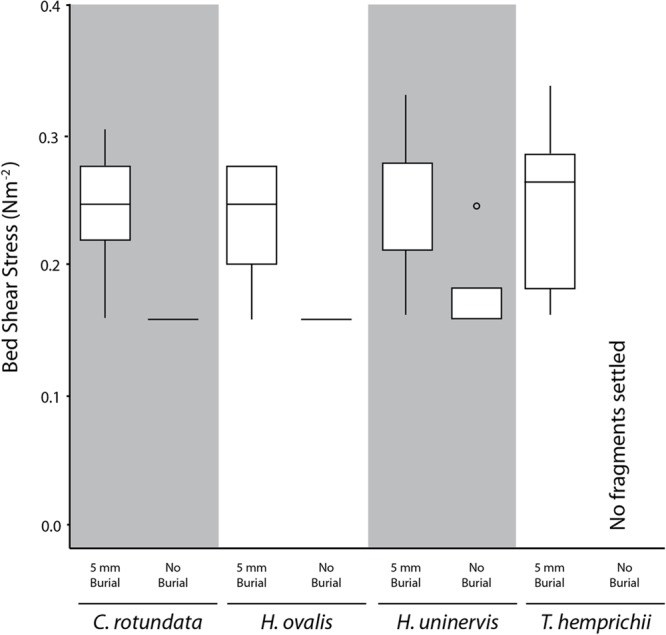
Box plot of the wave-generated bed shear stress (N m-2) needed to dislodge fragments of different species under 20 mm burial treatment. Midline represents 50% quartile, and top and bottom of each box represent 75 and 25% quartiles, respectively.